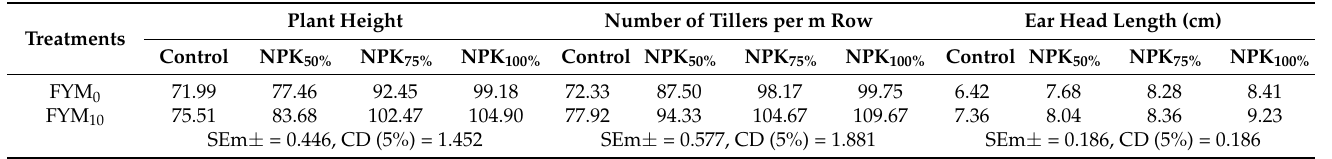
Table 3. Interaction effect of fertility levels and FYM on growth attributes of wheat (mean data of two years).